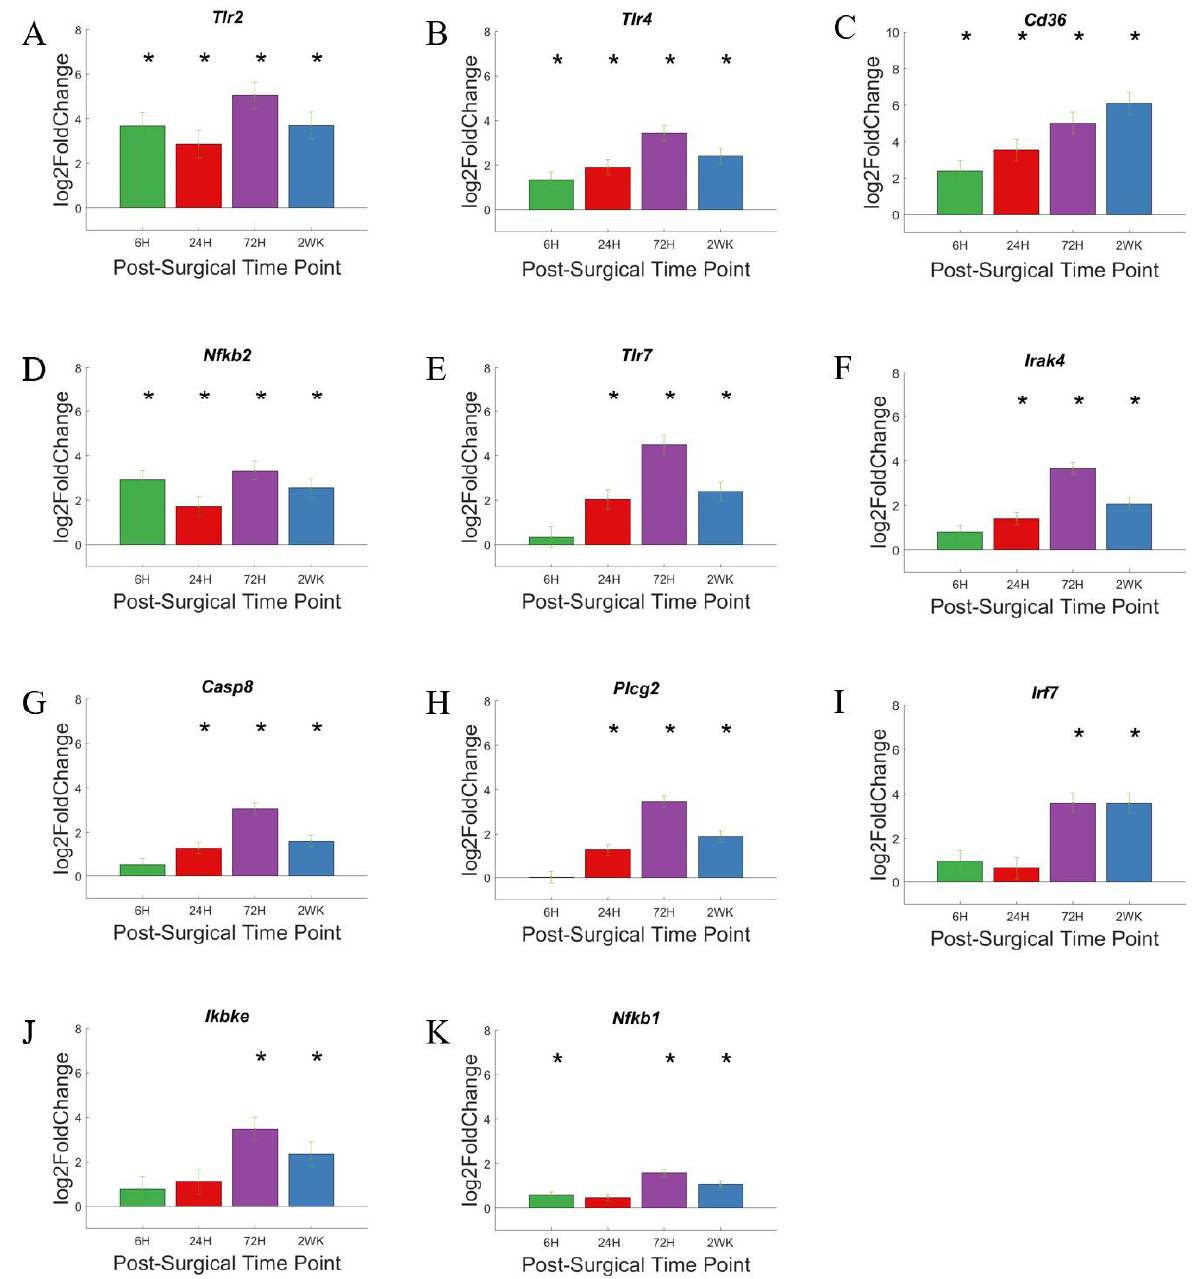
Figure 8. Differential expression of specific genes involved in the Toll-like receptor pathway compared to NSCTR mice: Bar graph of selected genes in the Toll-like Receptor’s pathway ( A – K ), alterations in expression are displayed as bar graphs of individual genes as a function of time post-surgery. For each time point, gene expression levels are compared to the NSCTR mice. Error bars indicate the standard error of the mean between NSCTR and each time point. Asterisks indicate that P adj < 0.05. Note ( C ), depicting the upregulation of Cd36 , has a y-axis log2foldchange scale of − 1 to 10, because of its high